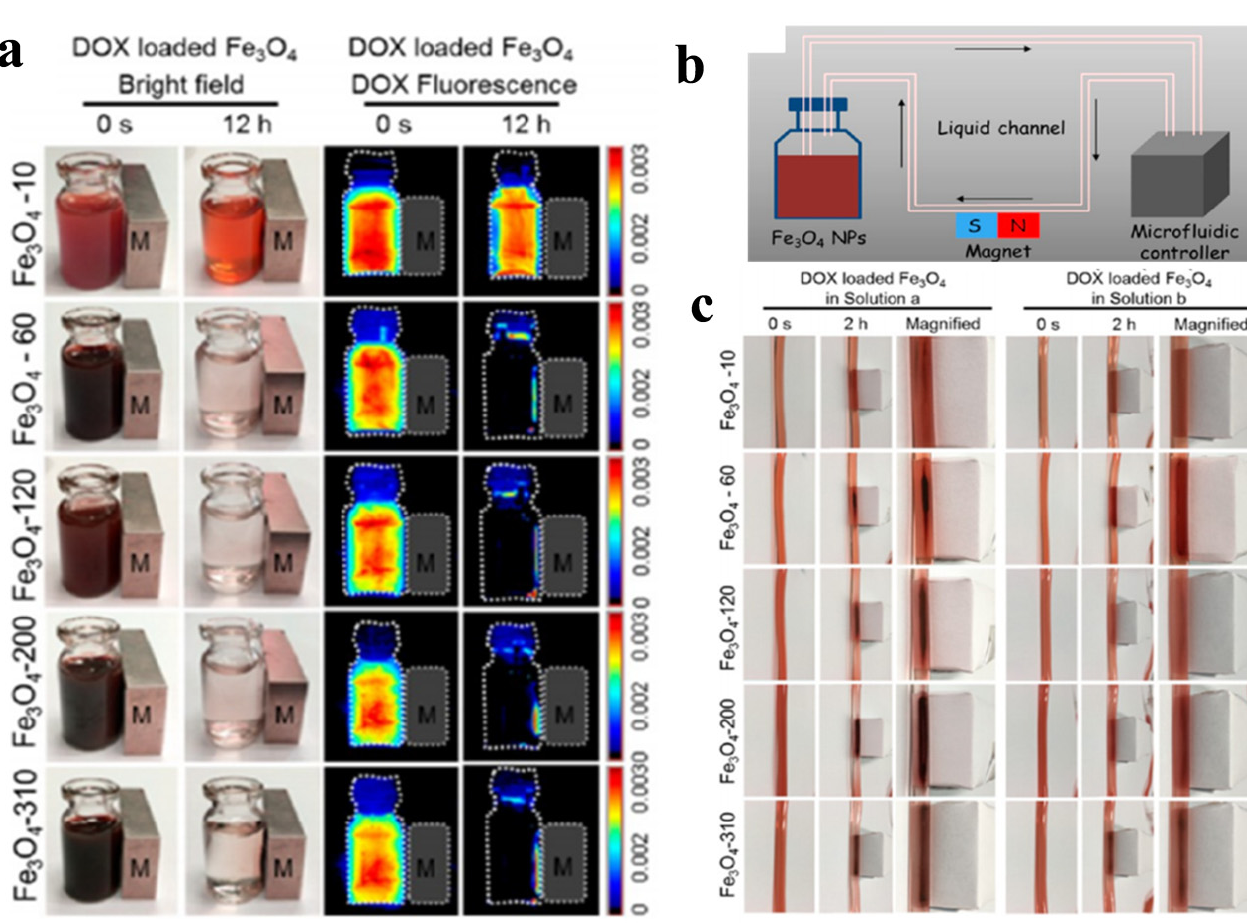
Figure 3. The in vitro magnetic responsiveness of iron oxide magnetic nanoparticles (MNPs) measuring 10 nm (Fe 3 O 4 -10), 60 nm (Fe 3 O 4 -60), 120 nm (Fe 3 O 4 -120), 200 nm (Fe 3 O 4 -200), and 310 nm (Fe 3 O 4 -310). ( a ) The images of fluorescent DOX-loaded MNPs before and after magnetic targeting with an external magnetic field in static mode. ( b ) A schematic diagram showing magnetic targeting in dynamic mode with a microfluidic system simulating nanoparticle retention in blood circulation, under the guidance of an external magnetic field. ( c ) The time-lapsed photographs of the magnetic retention of different nanoparticles in the flow system shown in ( b ) at the 32.85 cm/s flow rate found in the artery. Reprinted/adapted with permission from Ref. [97]. 2017, American Chemical Society.